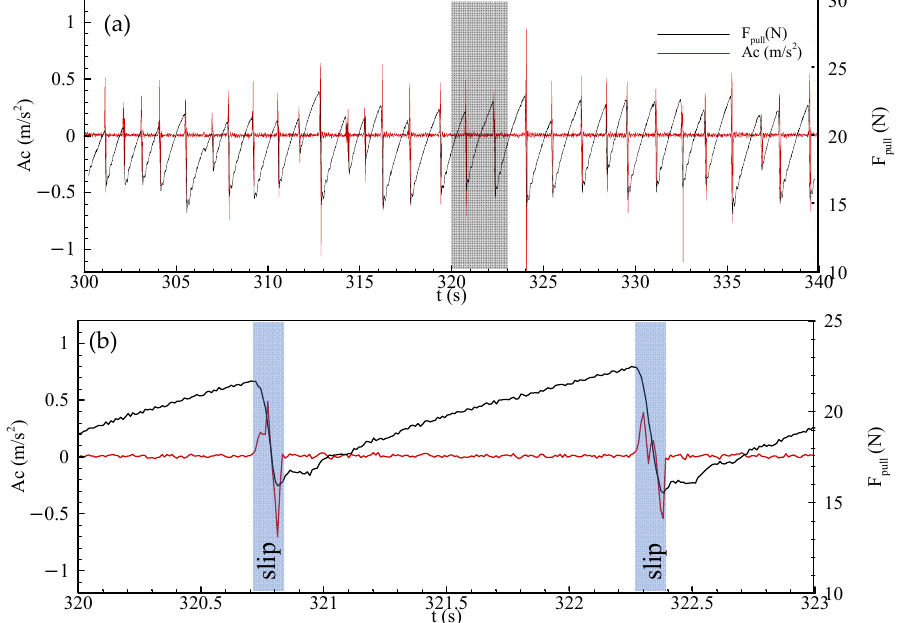
Figure 4. The pulling load and acceleration of an ACM pulling test (sg = 3.23, test in air). ( a ) the time history of 40 s. The shadow area indicates the zoom-in region. ( b ) zoom-in view over 3 s. The shaded areas in ( b ) indicate the two slips of the ACM.